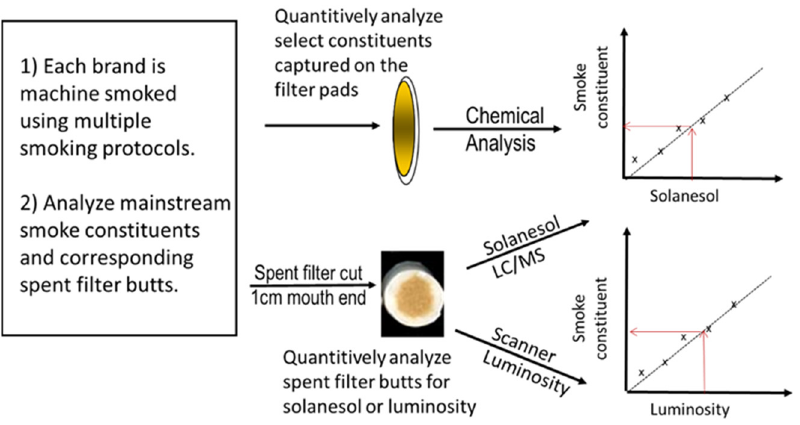
Figure 1. Protocol for measuring human smoke exposure using digital imaging and chemical analysis of spent cigarette filters.